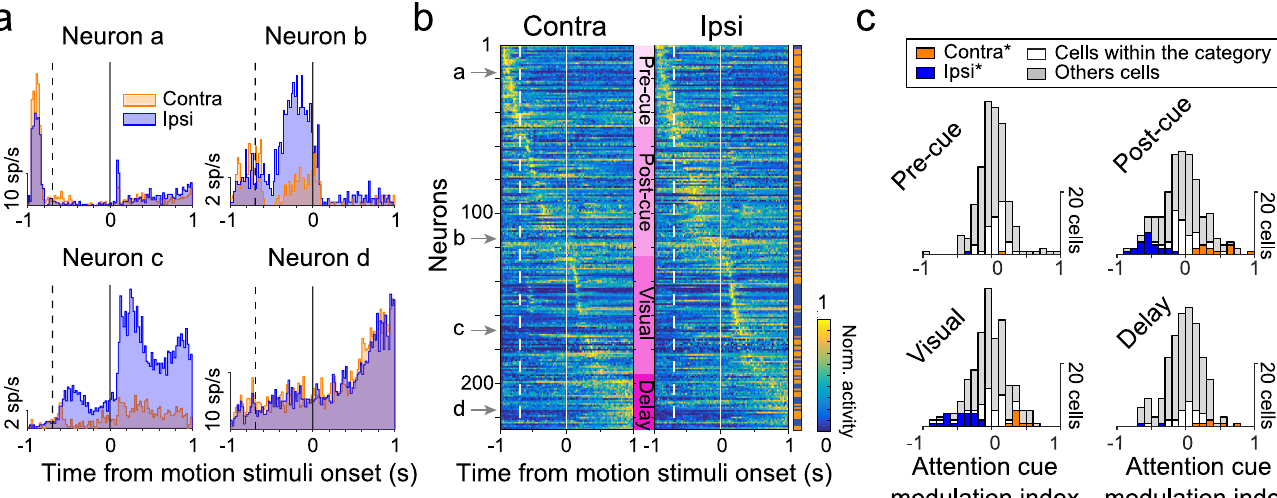
Fig 2. Caudate neuronal activity and cue-related modulation during the CD task. (A) Example caudate neurons. Activity of four different caudate neurons (a, b, c, and d) aligned on the onset of the motion patches (solid vertical line) when the cue was contralateral (“contra,” orange) or ipsilateral (“ipsi,” blue) with respect to the recording site. The dashed vertical lines indicate when the spatial cue was presented. (B) Normalized activity (“Norm. activity”) for our complete population of caudate neurons ( n = 227). Each row represents the normalized activity of a single neuron for contralateral presentation of the spatial cue (left) or ipsilateral presentation (right) aligned on motion stimuli onset. We computed normalized PSTHs by dividing the raw values from each time bin by the maximum firing rate (peak of each neuron’s PSTH) across all conditions (i.e., either contralateral or ipsilateral conditions, whichever was higher). Neurons were ranked according to the time of their peak activity across both contralateral and ipsilateral cue conditions. The colored sidebar on the right indicates whether each neuron had maximal activity for contralateral (orange) or for ipsilateral (blue). Solid white lines indicate onset of motion stimuli; dashed lines indicate spatial cue onset. Neurons were grouped according to the timing of the peak activity (labels in pink): before the spatial cue onset (Pre-cue), between the spatial cue and the motion stimuli onset (Post-cue), after the motion stimuli onset (Visual), and during the delay period prior to motion-direction change (Delay). (C) Spatial cue modulation in caudate nucleus. The histograms display the distribution of attention cue modulation index values for the periods for each group of neurons. The p -values were corrected with the Holm’s variant of the Bonferroni method. White bars indicate the cells within the appropriate category (pre-cue, post-cue, visual, or delay), whereas gray bars illustrate the cells out of the category. Colors indicate significant side preference (orange for contralateral, blue for ipsilateral, white for neither; Wilcoxon rank sum test, p < 0.05). Underlying data available in S1 Data. CD, change-detection; PSTH, peristimulus time histogram; sp/s, spikes per second.